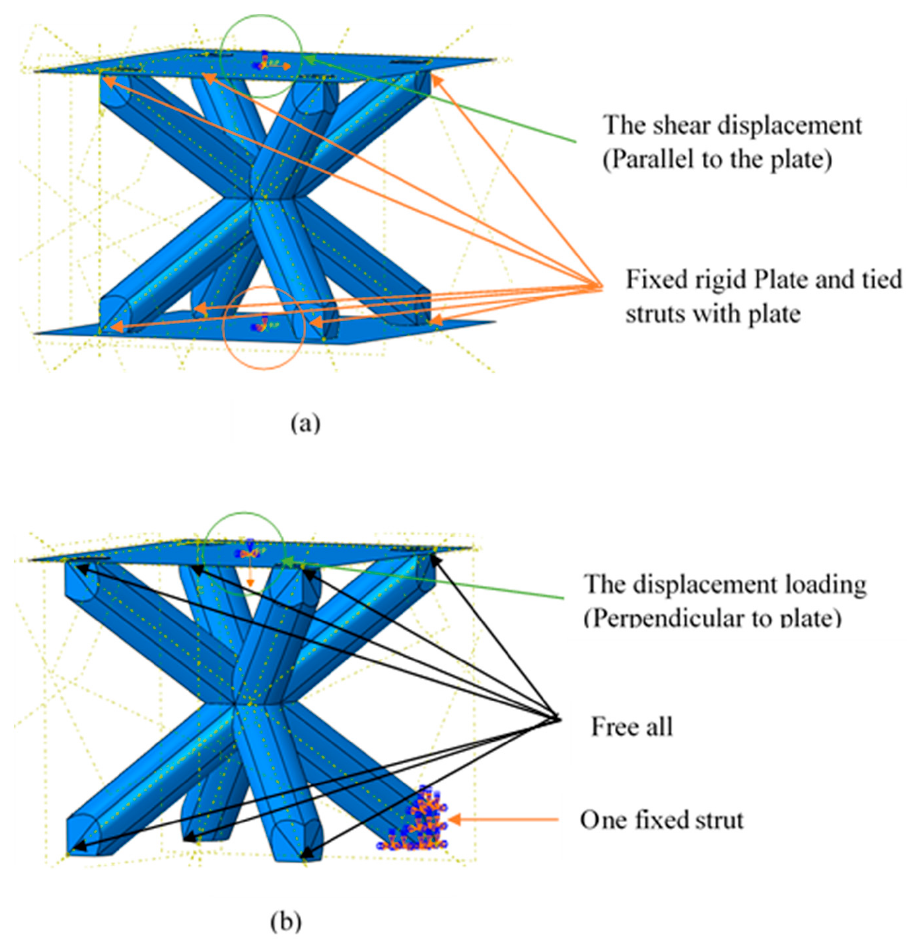
Figure 5. Boundary conditions of BCC unit cell for FEA model ( a ) Boundary condition for Shear modulus ( b ) Boundary condition for Elastic modulus and Poisson’s ratio. Table 1. Material properties of Acrylonitrile Butadiene Styrene (ABS) material